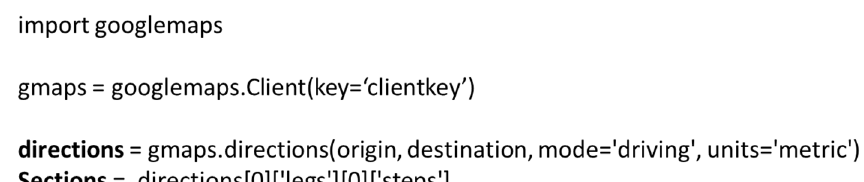
Figure 5. Commands to get sections information of the route in Python.